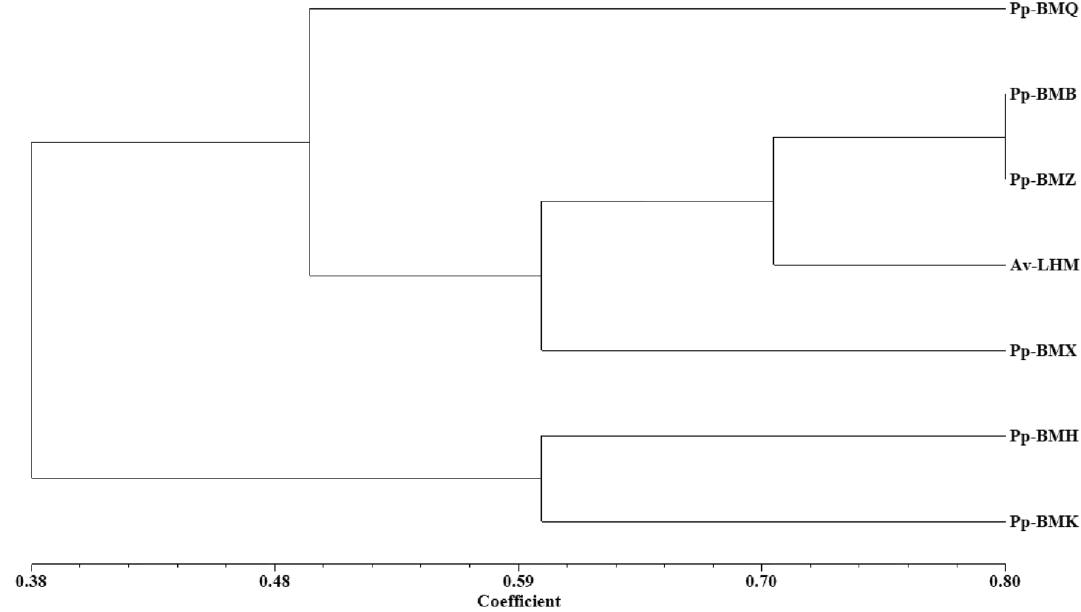
Figure 9. UPGMA (Unweighted pair-group method with arithmetic average) dendrogram generated from the incedence and disease index of seven ecotypes caused by B. exigua var. rhapontica . The cophenetic coefficient, r = 0.73.